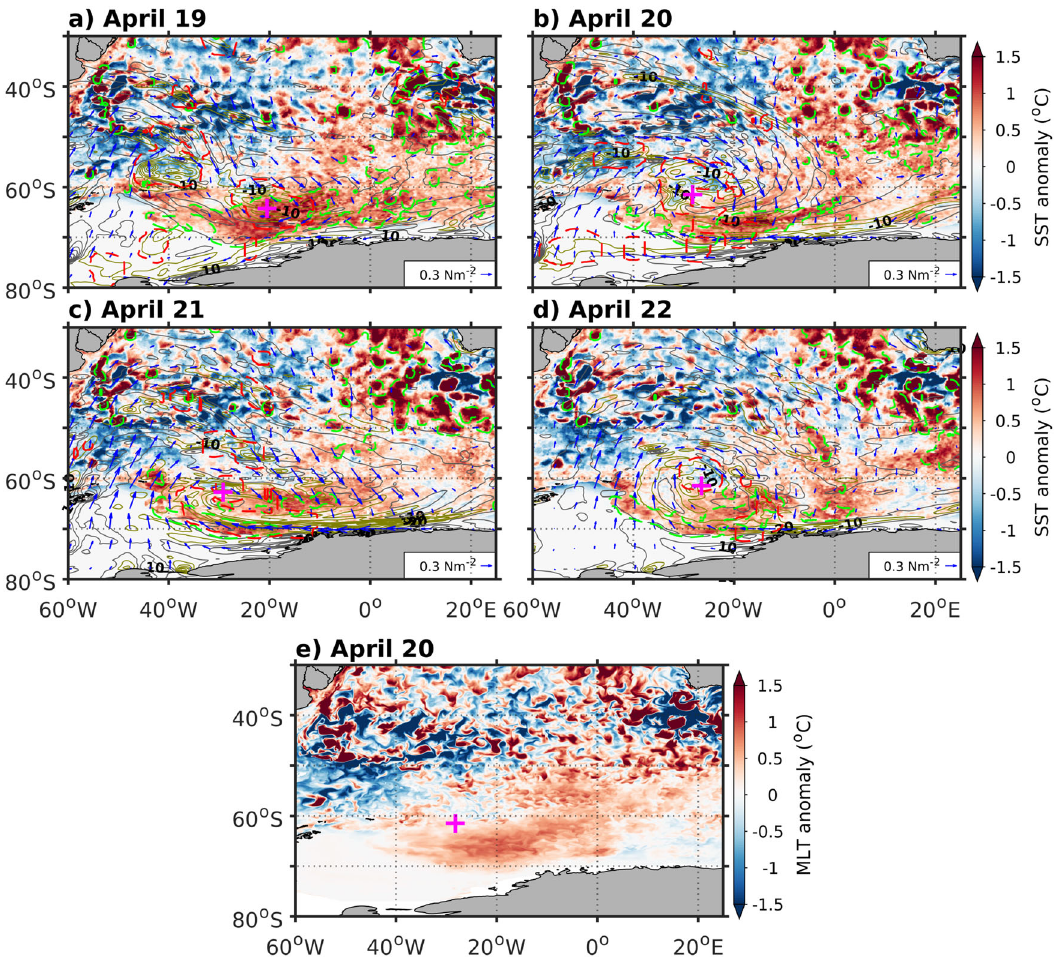
Fig. 7 Upper ocean thermal response to explosive cyclones. a – d Anomalies in sea surface temperature (SST), wind stress vectors (blue arrows), negative wind stress curl (green contours, N m − 3 ) and positive wind stress curl (gray contours) during 19 ‒ 22 April 2019. e Ocean mixed layer temperature (MLT) anomaly during 20 April 2019 (see Methods section ‘ Upper ocean temperature ’ ). Regions within red (green) dashed polylines have record low (high) values that remain outside from 1979 to 2020. Within this, the record low is shown for wind stress curl, while the record high is shown for the ocean temperature. The pink plus mark shows the low-pressure centre of the cyclone. The anomalies are computed relative to the climatology of 1979 –